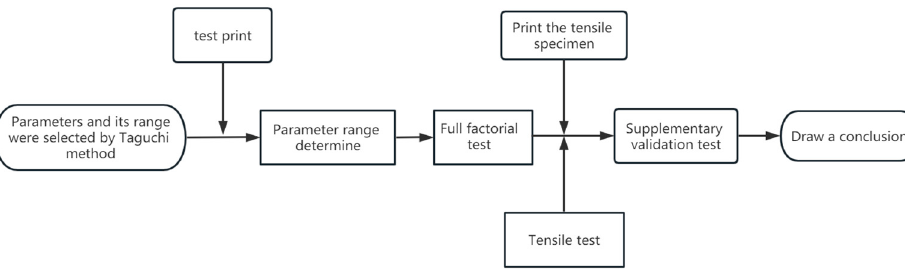
Figure 3. Flowchart of the experiment.